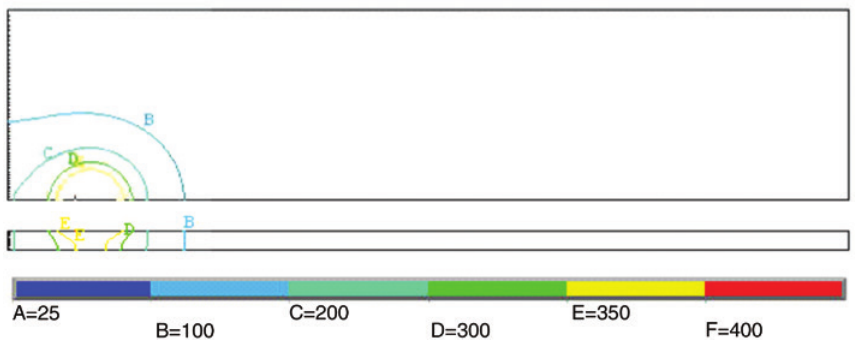
Figure 8: The temperature field in the preheating period.